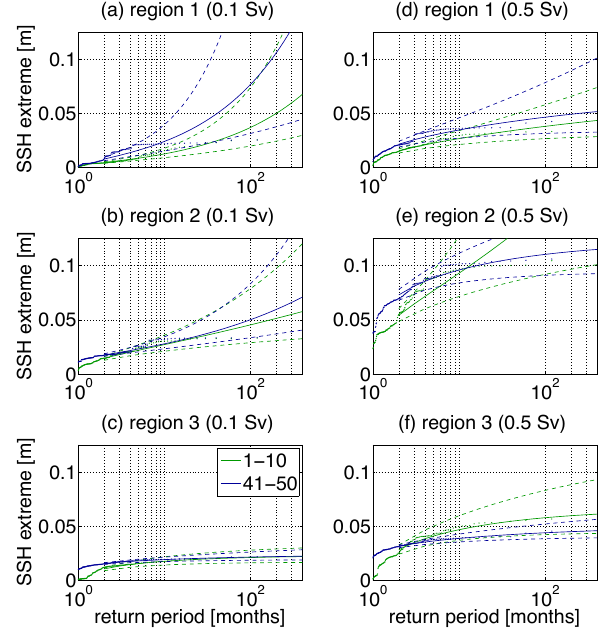
Fig. 8. Generalized extreme value (GEV) distribution fits to monthly maximum SSHP changes in the different Figure 8. Generalised extreme-value (GEV) distribution fits regions; (a-c) GEV plots for the 0.1 Sv LR simulation and (d-f) GEV plots for the 0.5 Sv LR simulation. The to monthly maximum SSHP changes in the different regions; extremevaluesareplottedasafunctionofreturntimesusing10yearsofdataatthebeginningofthesimulation (a–c) GEV plots for the 0.1Sv LR simulation and (d–f) GEV plots (green: years 1-10) and for a similar period at the end of the simulation (blue: 41-50). The dashed curves for the 0.5Sv LR simulation. The extreme values are plotted as a indicate the 95% confidence interval corresponding to the GEV fit. The low-frequency signal is filtered out function of return times using 10 years of data at the beginning of before determining the extreme values. the simulation (green: years 1–10) and for a similar period at the end of the simulation (blue: 41–50). The dashed curves indicate the 95% confidence interval corresponding to the GEV fit. The low- frequency signal is filtered out before determining the extreme val- ues.